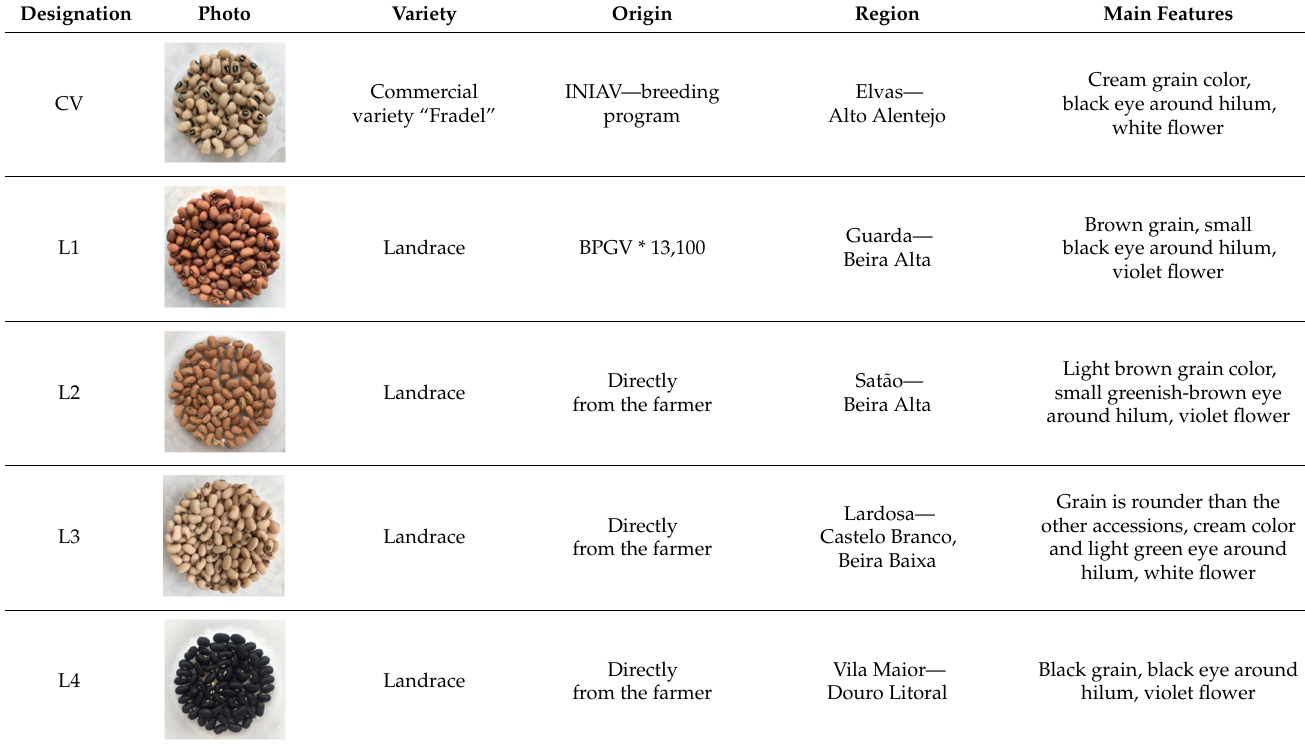
Table 1. Designation and origin of the cowpea genotypes under study.